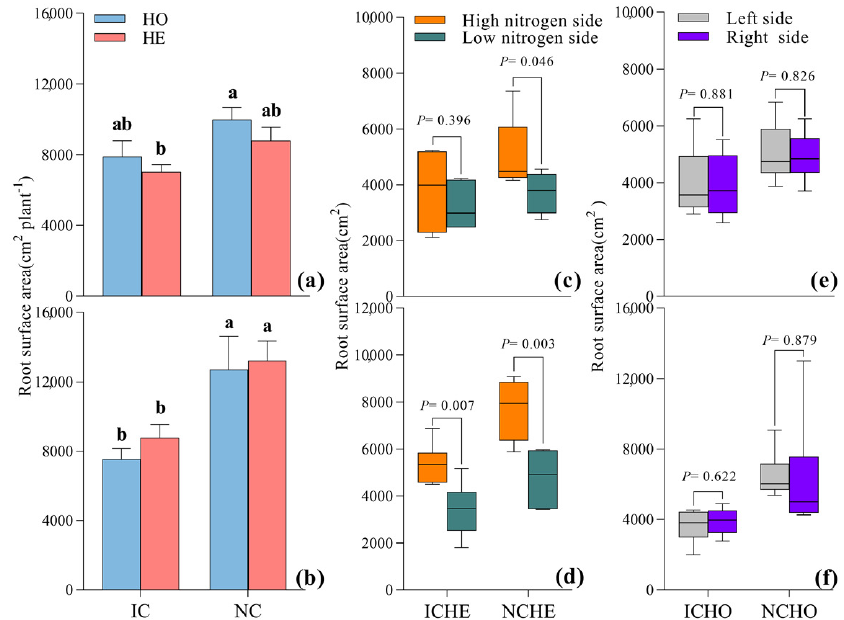
Figure 8. Effect of nitrogen distribution pattern on root surface area. ( a ) Root surface area at flowering stage. ( b ) Root surface area at mature stage. ( c ) Root surface area at flowering with heterogeneous distribution of nitrogen. ( d ) Root surface area at mature with heterogeneous distribution of nitrogen. ( e ) Root surface area at flowering with homogeneous distribution of nitrogen. ( f ) Root surface area at mature with homogeneous distribution of nitrogen.